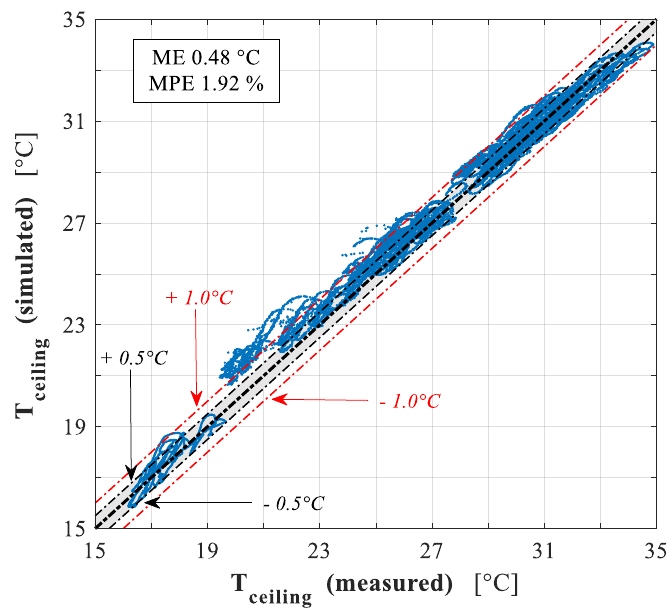
Energies 2019 , 12 , x FOR PEER REVIEW Figure 24. Ceiling temperature: simulated vs. experimental results (from February to November).